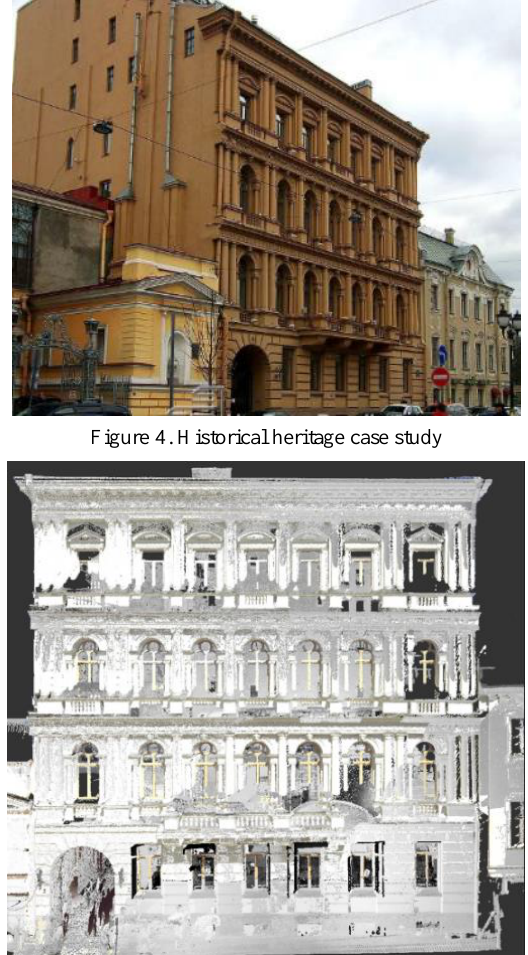
Figure 5. Processed point cloud for historical heritage case